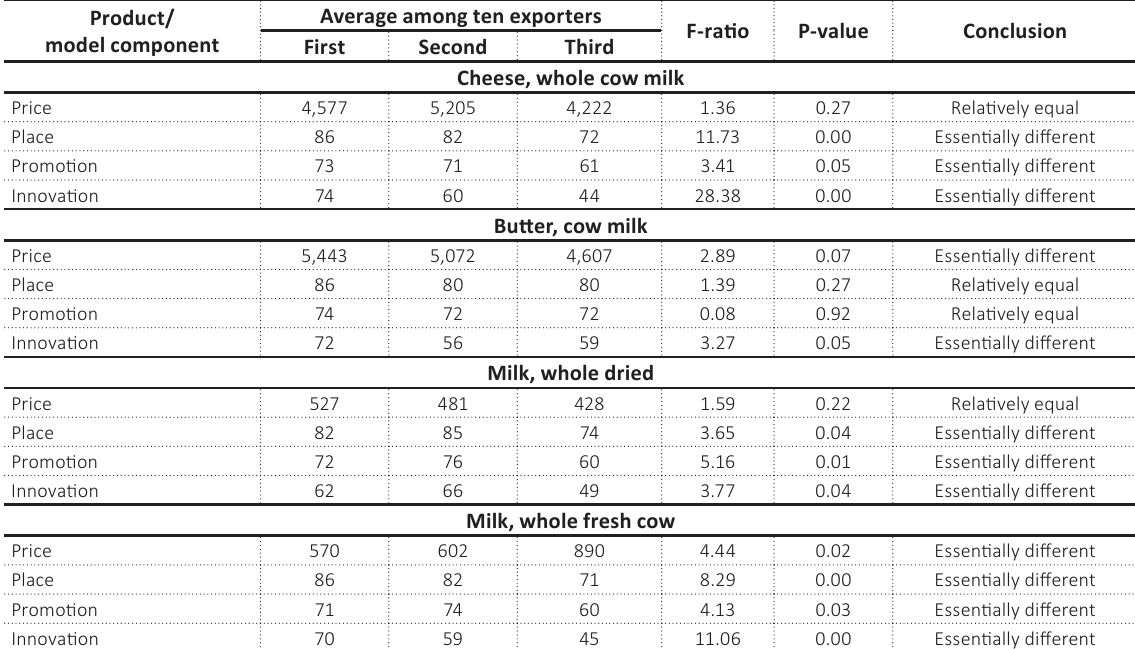
Source: Computed by the